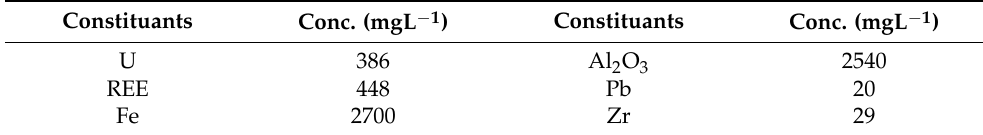
Table 8. Chemical composition of the prepared leach liquor at (pH = 0.3).